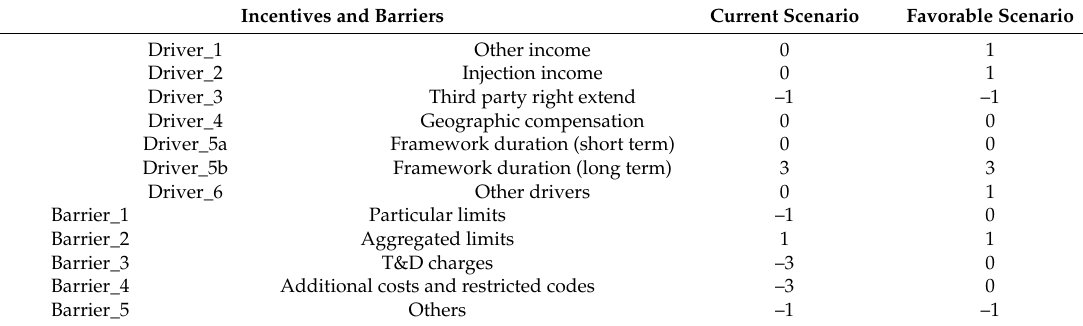
Table 5. Impact of regulations on the incentives and barriers to self-consumption in current and the favorable